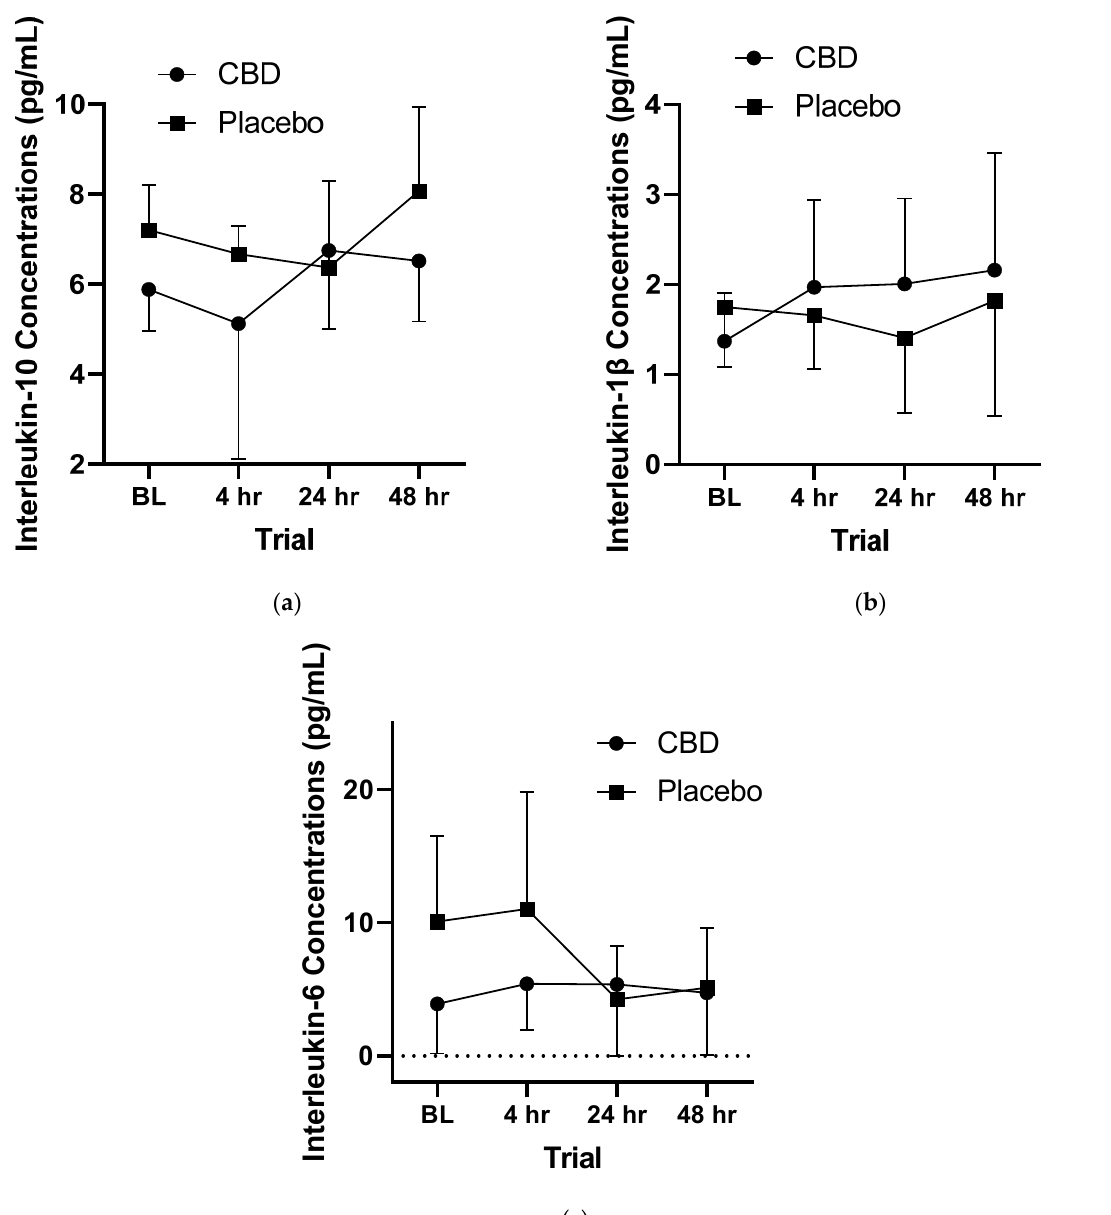
Figure 2. Concentrations (pg/mL) of ( a ) interleukin ‐ 10, ( b ) interleukin ‐ 1 β , and ( c ) interleukin ‐ 6 at various timepoints. BL = 2 h prior to muscle damaging protocol, 4 hr = 4 h post ‐ muscle damaging protocol, 24 hr = 24 h post ‐ muscle damaging protocol, 48 hr = 48 h post ‐ muscle damaging protocol. ( n = 24).